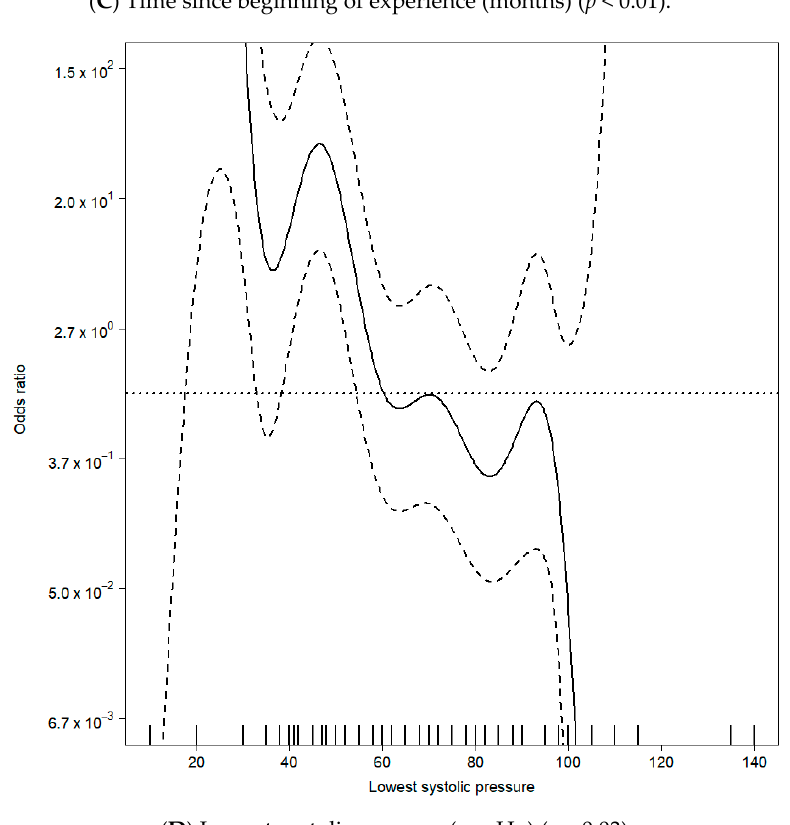
Figure 3. Multivariable association between high-severity adverse events and patient and procedural characteristics. ( A ) Age (months) ( p = 0.05); ( B ) weight (kg) ( p < 0.01); ( C ) time since beginning of experience (months) ( p < 0.01); ( D ) lowest systolic pressure (mmHg) ( p = 0.03). There was a multivariable association between high-severity adverse events and (A) age (months) ( p = 0.05), (B) weight (kg) ( p < 0.01), (C) time since beginning of experience (months) ( p < 0.01) and (D) lowest systolic pressure (mmHg) ( p = 0.03). Estimated high- severity adverse events odds ratio curves of continuous covariates were derived from the generalized additive model with thin-plate regression splines. For each observed value on the x-axis, small vertical lines are displayed on the bottom of each Figure 3A–D. 3.4. Predictors of Requirement for Additional Hemodynamic Support General anesthesia cases had a higher rate of requirement for additional hemodynamic support (34%) than sedation cases (8%, p < 0.01) (Table 3). The role of patient and procedural characteristics in the requirement for additional hemodynamic support was evaluated using univariate and multivariable analysis (Table 7). In the multivariable model, the use of sedation (OR 0.1, 95% CI 0.1–0.2, p < 0.01), palliated status (OR 2.4, 95% CI 1.0–5.7, p = 0.05) and PAH (OR 7.1, 95% CI 3.0–16.9, p < 0.01) were independent predictors of the requirement for additional hemodynamic support. In a multivariable model using thin-plate regression splines with a maximal possible dimension of 10, we found that time since beginning of experience ( p < 0.01) was independently associated with the requirement for additional hemodynamic support (Figure 4). A plot of odds ratios using the multivariable spline fit showed the significant